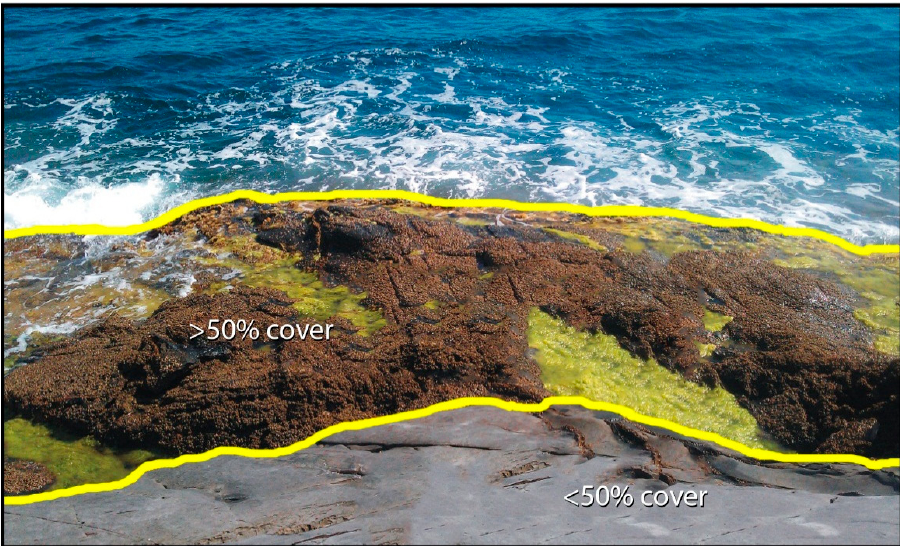
Figure 8. First order platform Chthamalus spp. coverage, Pontetto locality.